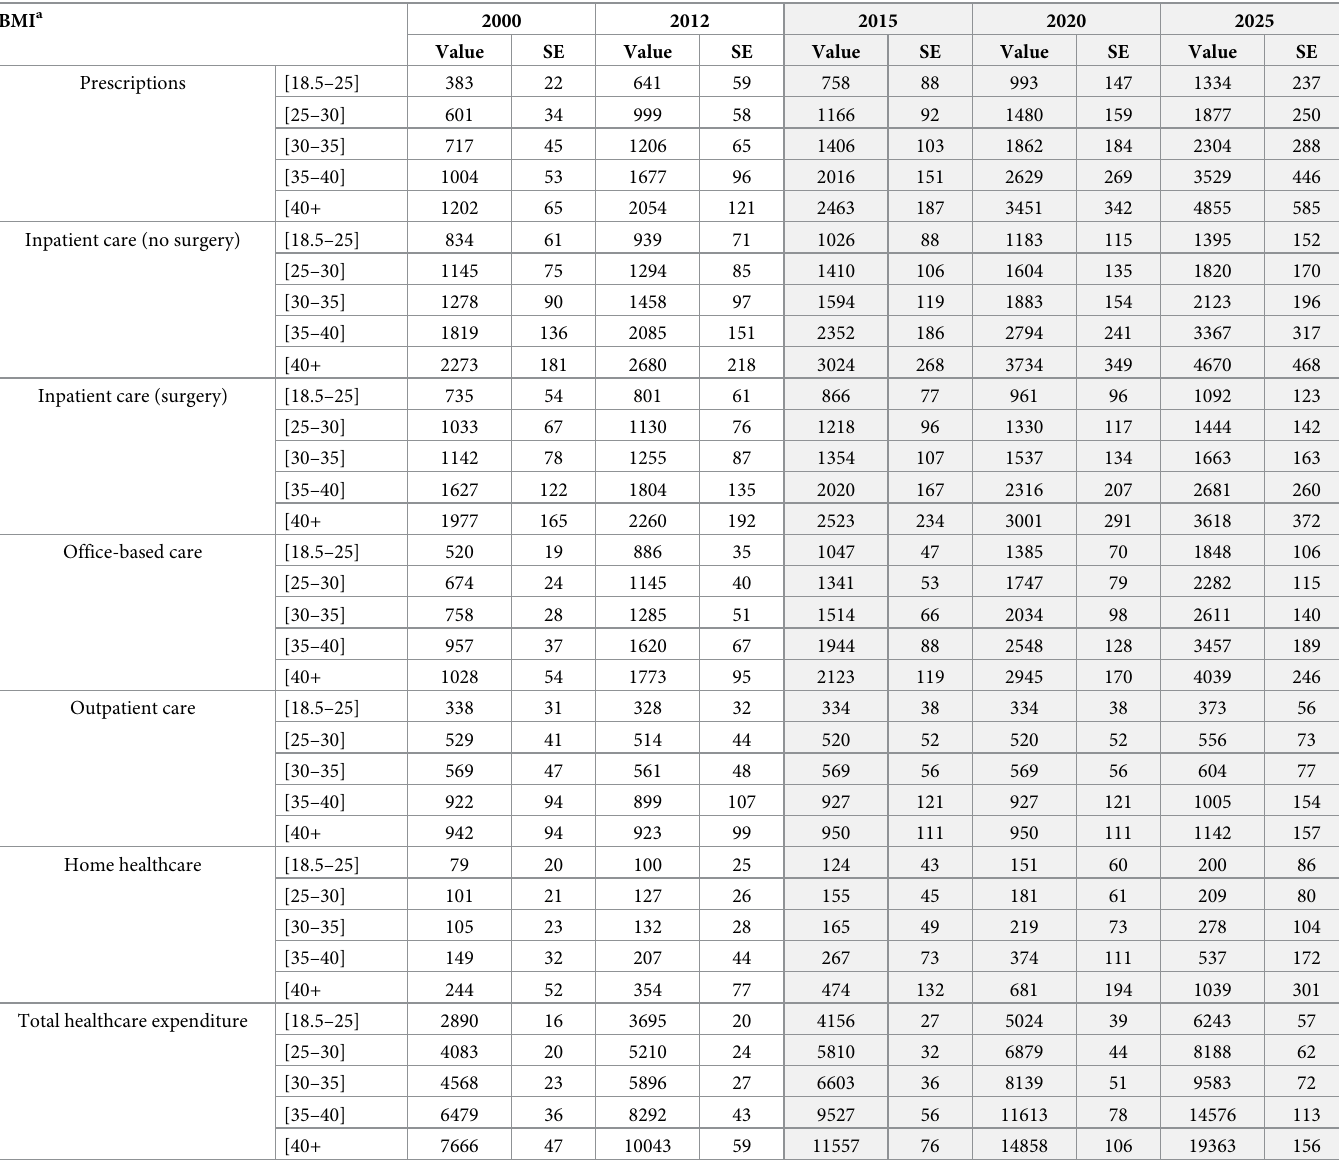
Table 3. Healthcare expenditure and (standard error) per capita by year, category of service and BMI; US population 2000–2025. BMI a